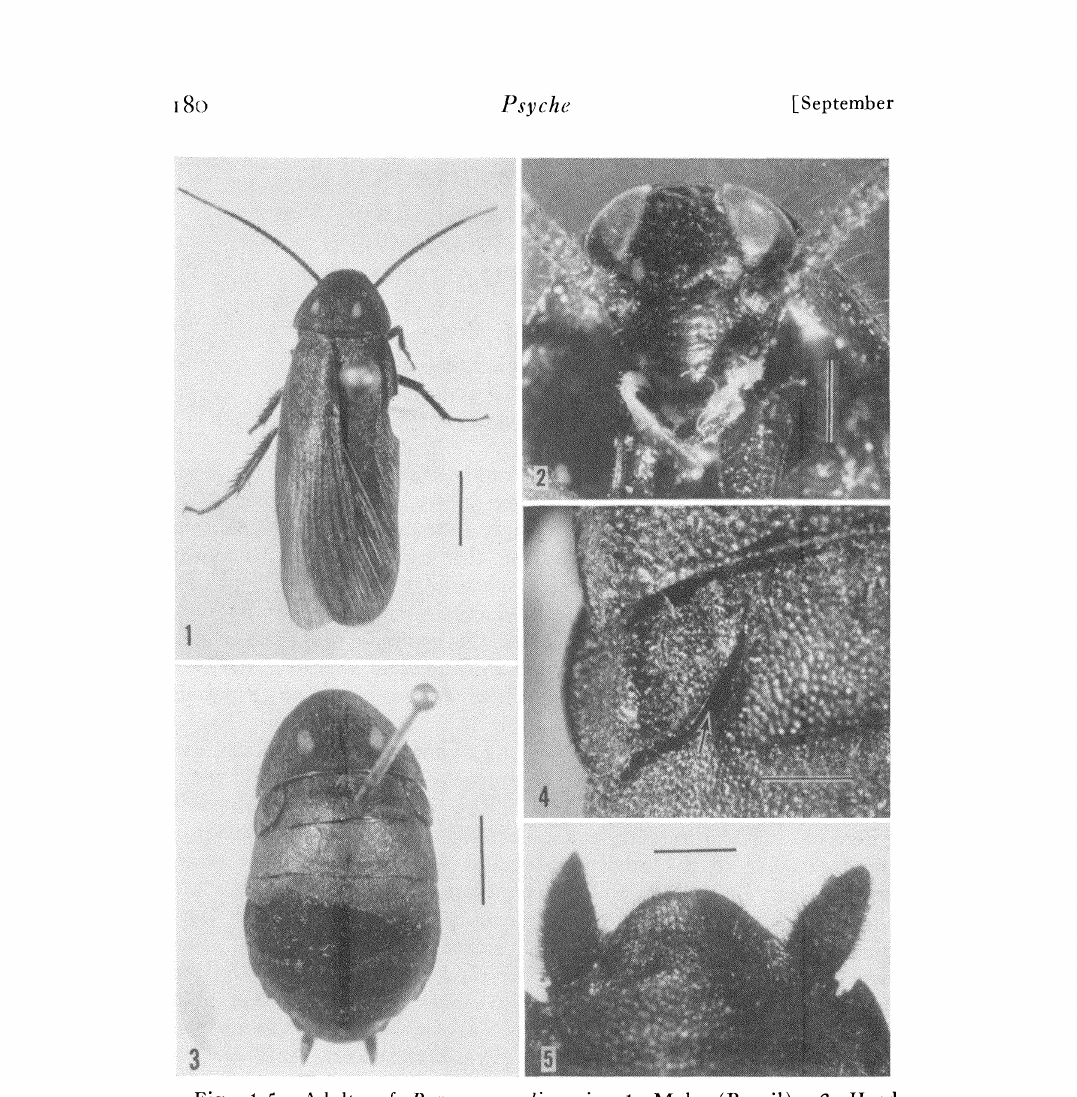
Figs. 1-5. Adults of Paramuzoa linearis. 1. Male (Brazil). 2. Head (O ) (From specimen shown in Fig. 1). 3. Female (Brazil). 4. Lef.t side of female mesonotum showing the deep, incomplete lateral incision (arrow) resulting in a tegmenlike lobe. 5. Supra-anal plate and cerci (dorsal) of figs. 2, 4-5